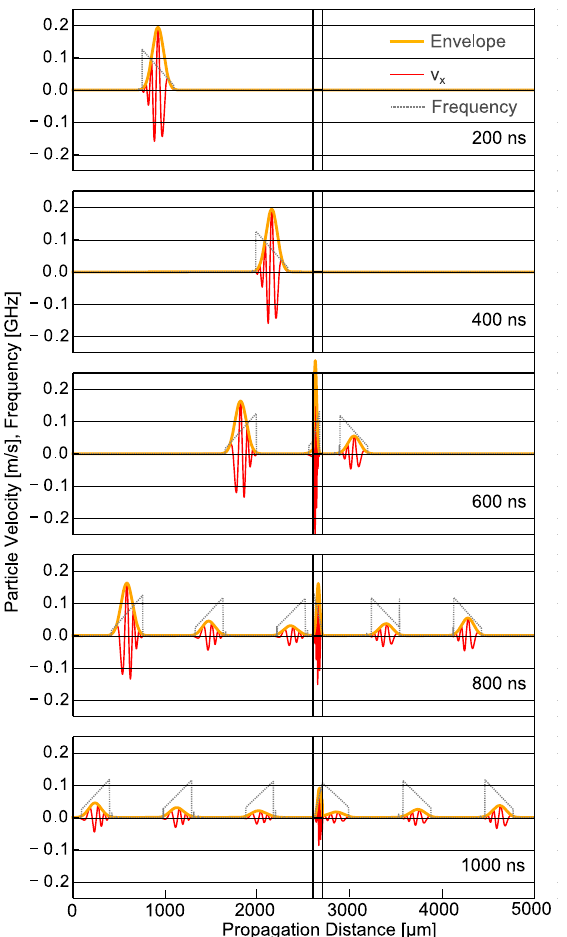
Figure 3 . The ringing effect of a chirped ultrasound wave packet (low frequencies in the front of the packet) in aluminum approaching a gap (cavity) of 100 μ m filled with water (indicated by the vertical parallel lines). Subsequent time-steps are shown at 200 ns and 400 ns before the wave packet reaches the cavity and for 600 ns, 800 ns, and 1000 ns, while the wave packet interacts with the cavity. The instantaneous frequency profiles are shown as gray dotted lines.